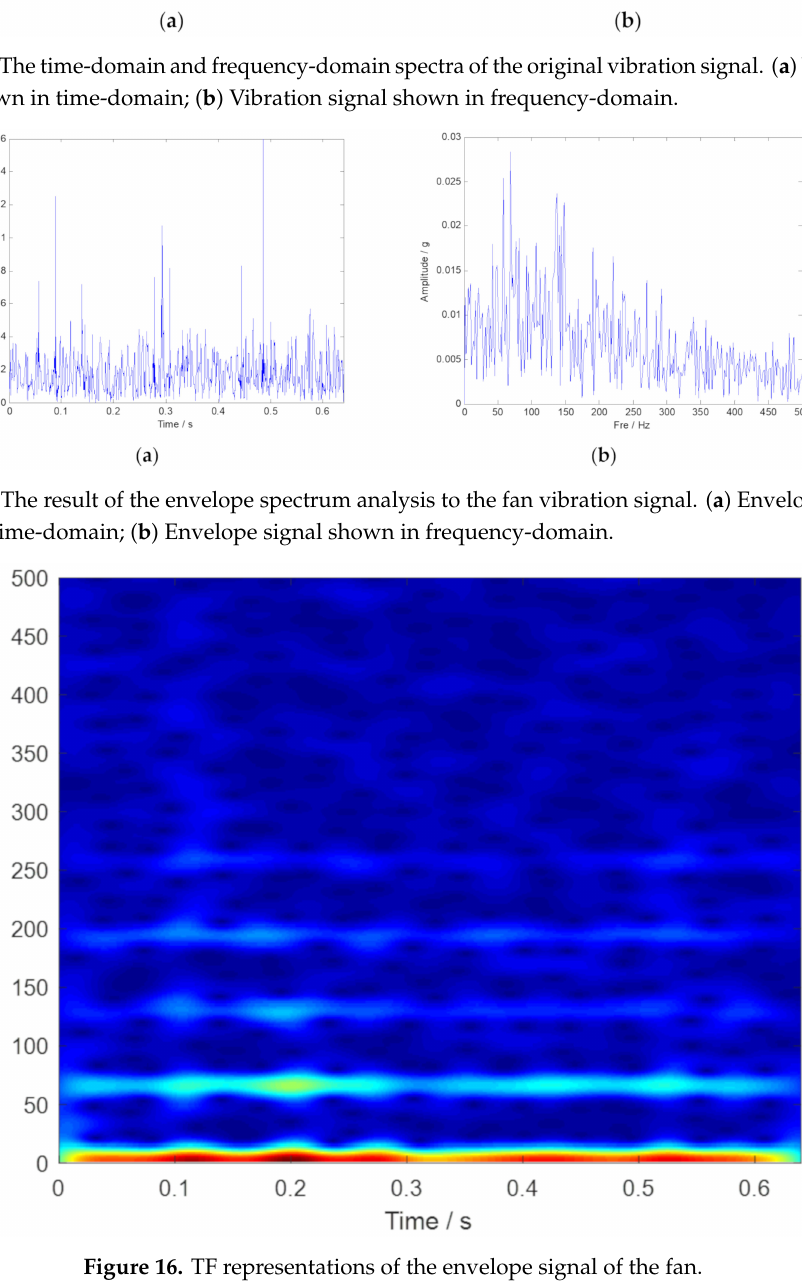
Figure 16. TF representations of the envelope signal of the